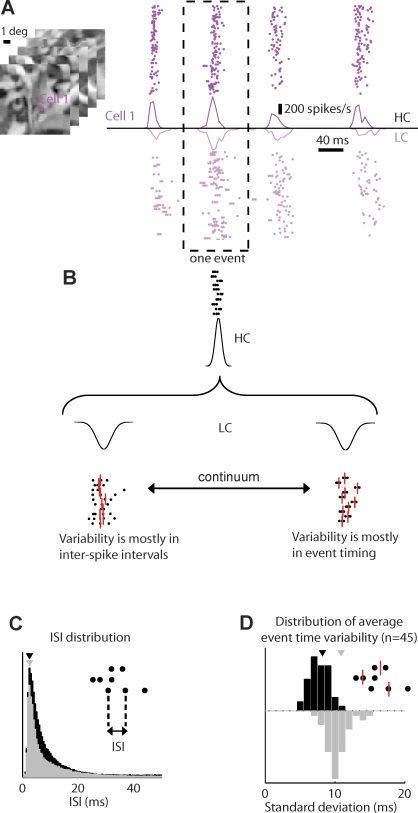
Spike Timing Precision in Single Cells(A) Movies of natural scenes were presented while recording from individual cells in the LGN. Left panel: The receptive field of a typical LGN X ON cell is superimposed, to scale, on the first frame of the natural visual stimulus. Right panel: Raster plots and PSTH for the response of this cell during a 500-ms segment of the movie, at HC and LC.(B) Possible sources of spike timing variability composing each PSTH event, where the red tick marks denote the median time of each event.(C) Distribution of ISIs (as defined in inset) over all cells (n = 45), at HC (black) and LC (gray). Arrows indicate distribution peaks.(D) Distribution of the variability in median event time (as defined in inset) for all events in all cells, at HC (black) and LC (gray).